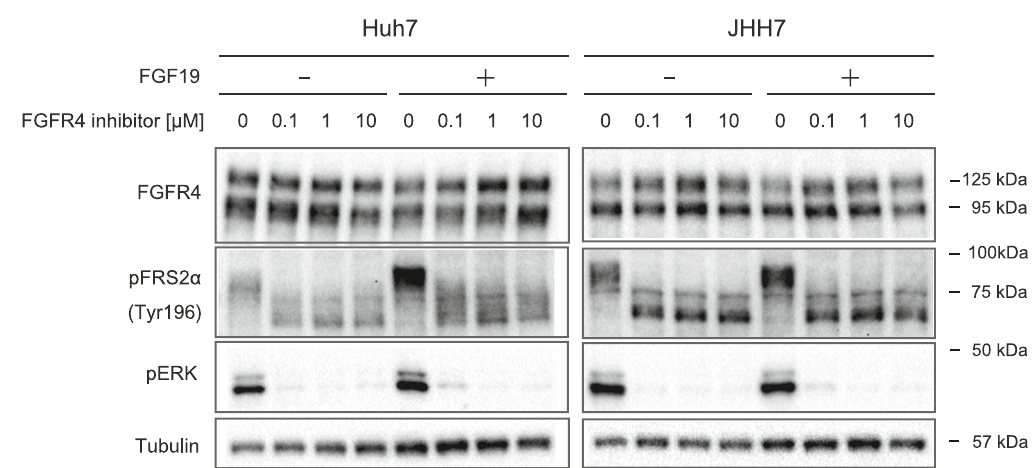
Figure 2. In vitro assays of FGF19-stimulated HCC cells. ( A ) Proliferation of HCC cells transduced with the indicated lentiviruses in culture 96 h after seeding. These data were from three independent experiments. *Significant ( p < 0.05). ( B ) Cells treated with FGF19 and/or a FGFR4 inhibitor were subjected to Western blot analyses using anti-FGFR4, anti-pFRS2α, anti-pERK and anti-tubulin (loading control)